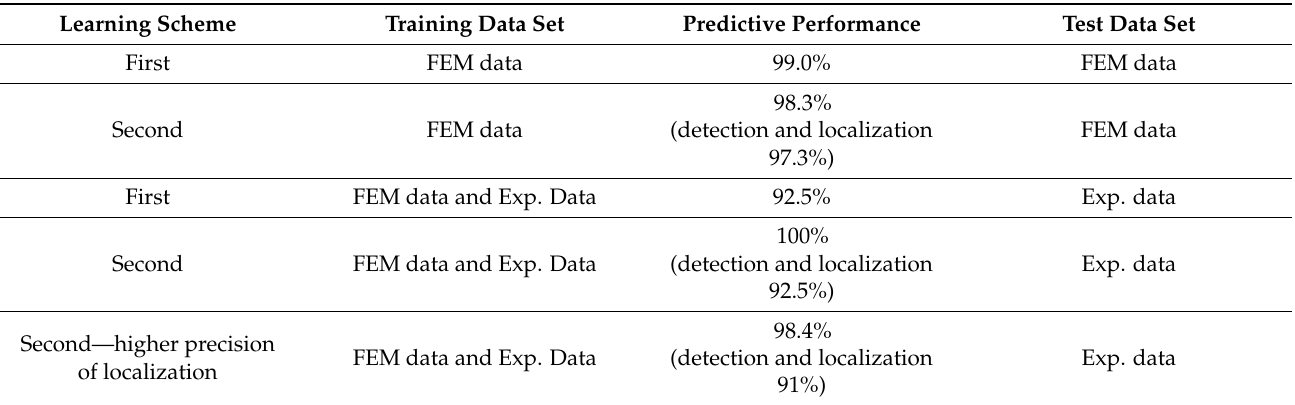
Table 8. Overall classification results for the presented